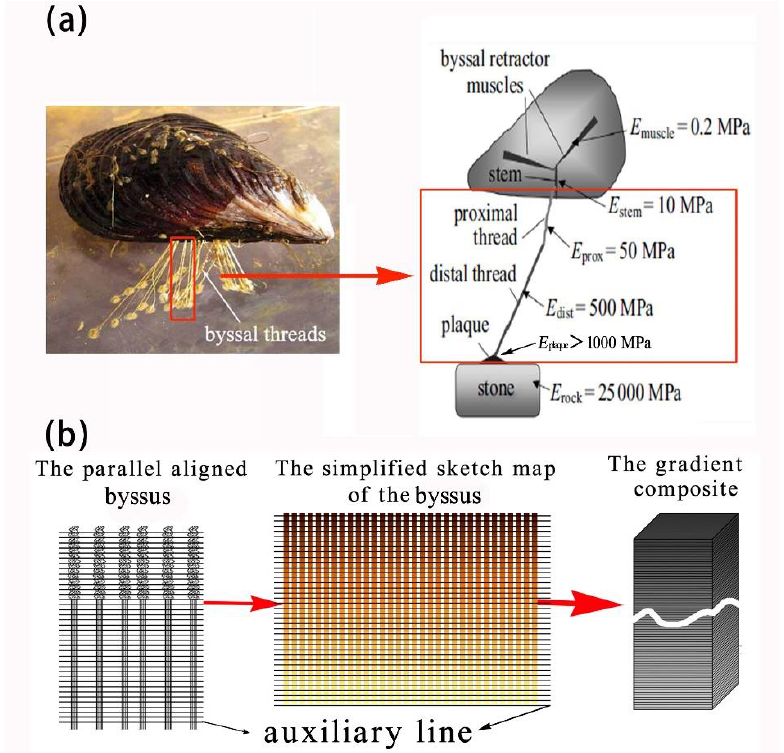
Figure 2. ( a ) The schematic drawing of the mussle byssus. The byssal thread is a gradient structure along the axial direction. Modulus of the plaque is higher than 1 GPa, while the modulus of the proximal threads is only around 10 MPa; ( b ) When byssus are parallel aligned, the close-set threads looks like a holistic structure (the gradient composite).